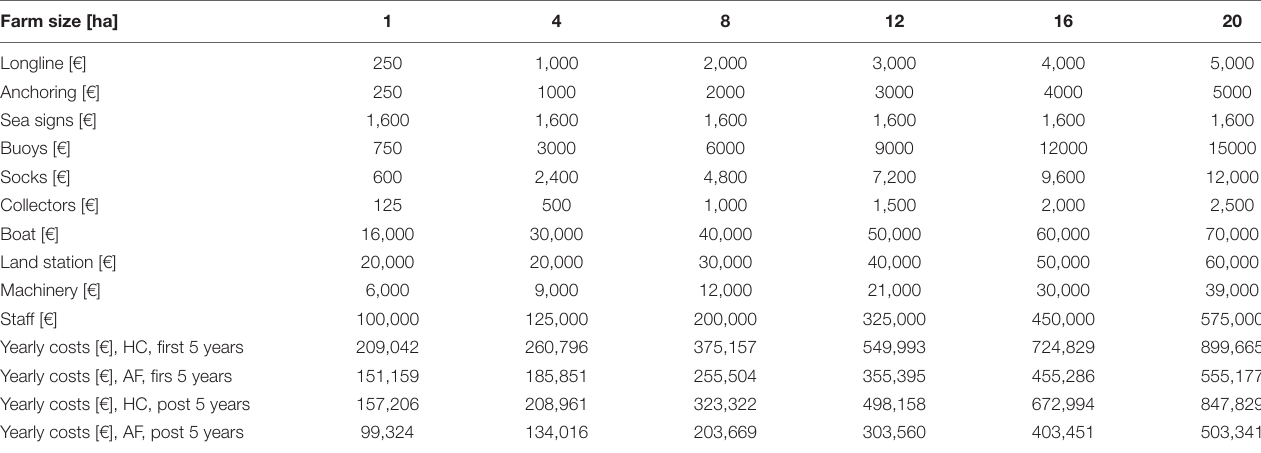
TABLE 2 | Yearly costs [EUR, €] for mussel farms of different size and usages: human consumption (HC) and animal feed (AF); divided into running costs including (first 5 years) and excluding (post 5 years) investment cost. Farm size